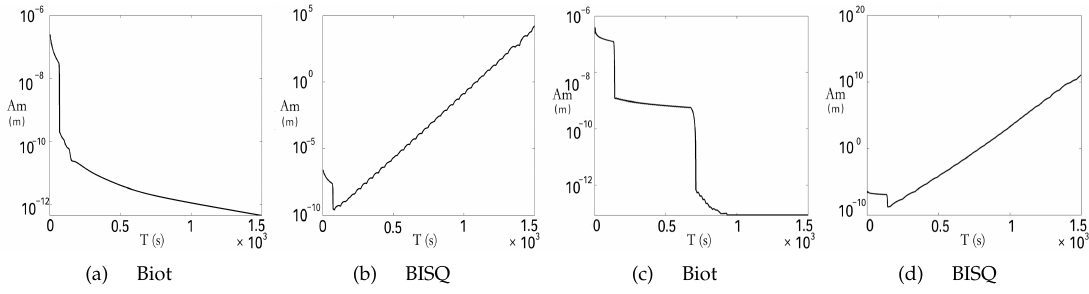
Figure 2. Changes of amplitude. ( a , b ): the scheme (4)/(6)/(7); ( c , d ): the scheme